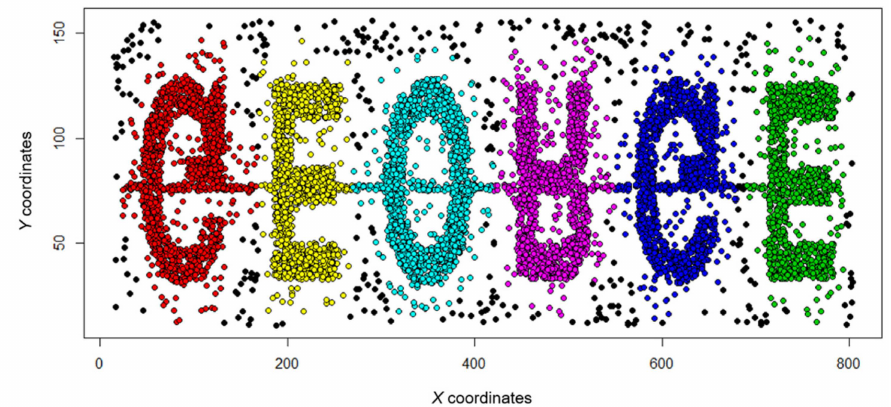
Figure 6. Results of spatiotemporal clustering using